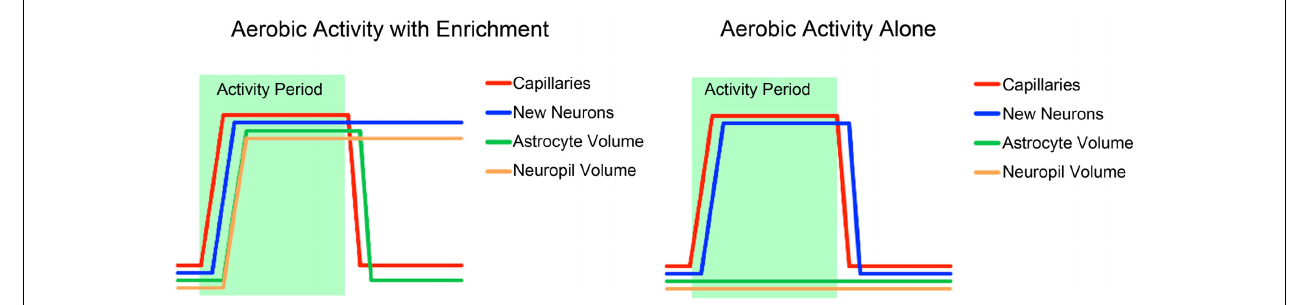
FIGURE 3 |A schematic summary of the time courses of the different components of structural change associated with exercise and environmental enrichment, based on several studies discussed in this review (Black et al., 1990; Kleim et al., 2007;Van der Borght et al., 2009; Kempermann et al.,